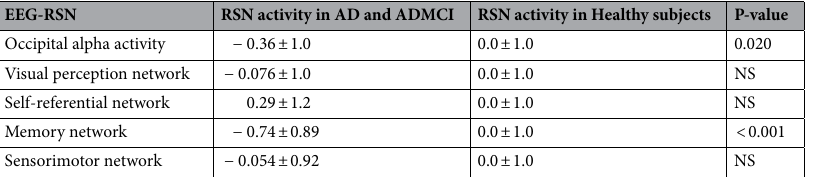
Table 2. Z-scores of EEG resting-state network (RSN) activities in AD and ADMCI patients, and healthy subjects. Data are mean ± standard deviation of z-scores of EEG-RSN activities after healthy age-related changes were corrected using linear regression analysis. RSN, resting state network; AD, Alzheimer’s disease; ADMCI, Mild cognitive impairment due to AD; NS, not significant. The differences between age-corrected RSN activities of the patients (90 AD and 11 ADMCI) and 147 healthy subjects were assessed by independent Student’s t-test with Holm correction.